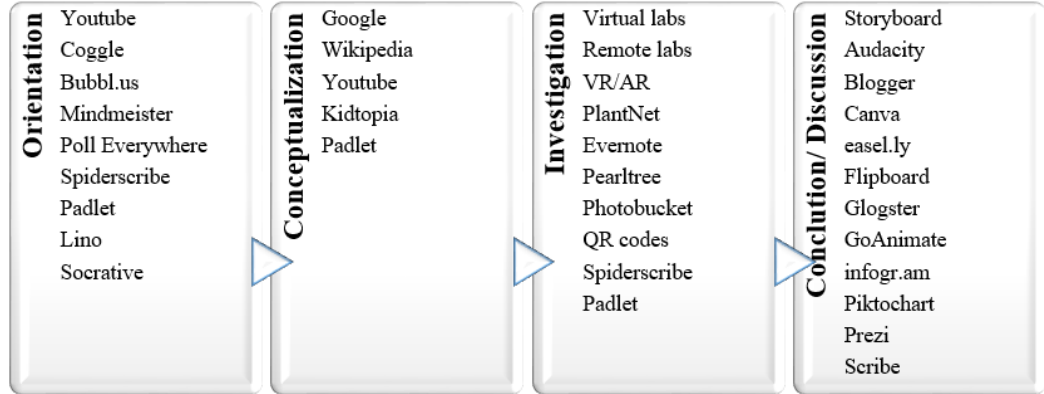
Figure 8: Tools for research and cognitive learning.